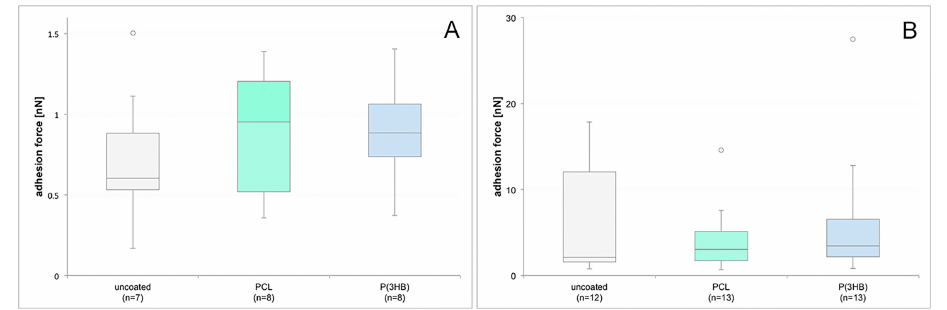
Figure 11. Number of GFP-osteoblasts on uncoated, PCL-coated and P(3HB)-coated titanium scaffolds in the course of 7 days ( A ), as well as the populated area of these implants ( B ) and the cell spreading area of the osteoblasts ( C ) in the same temporal dimensions. Using the F-test for interaction between time and materials significant differences could be revealed between the populated area of uncoated and both PCL- and P(3HB)-coated scaffolds. Also, significant differences could be found for the cell spreading area of uncoated scaffolds compared to coated ones (circles = single values for uncoated titanium scaffolds, triangles = single values for PCL coated scaffolds, rhombi = single values for P(3HB)-coated scaffolds, lines = regression curves).